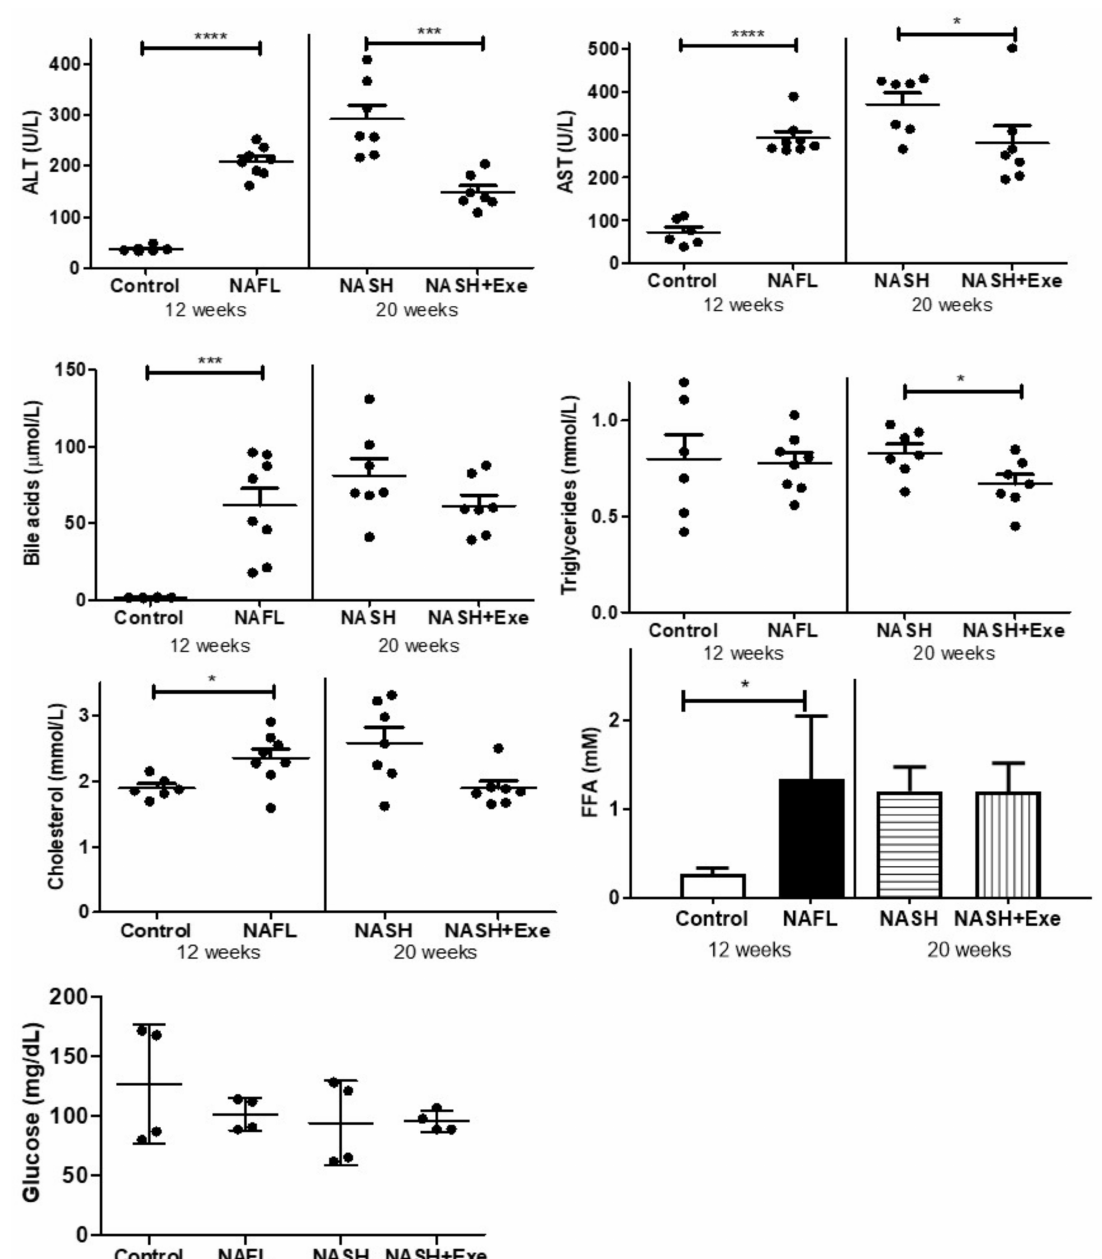
Figure 4. Effectofexerciseonbiochemicalvaluesinplasma. Plasmaconcentrationsofalaninetransaminase (ALT), aspartate transaminase (AST), total bile acids, triglycerides, cholesterol and free fatty acids (FFA), and fasting blood glucose were compared in mice fed a control diet or a choline-deficient high-fat diet (CD-HFD) for 12 weeks (NAFL), and in mice fed a CD-HFD for 20 weeks with (NASH + EXE) or without exercise (NASH). ALT and AST were higher in NAFL than in controls, and higher in NASH sedentary than in NASH + EXE (unpaired t -test; * p < 0.05; *** p < 0.001; **** p < 0.0001). Bile acids were elevated in NAFL vs. controls ( p < 0.001). Triglycerides were lower in NASH + EXE than in NASH sedentary ( p < 0.05). Cholesterol was higher in NAFL than in controls. FFA was higher in NAFL than in controls (unpaired t -test; p <